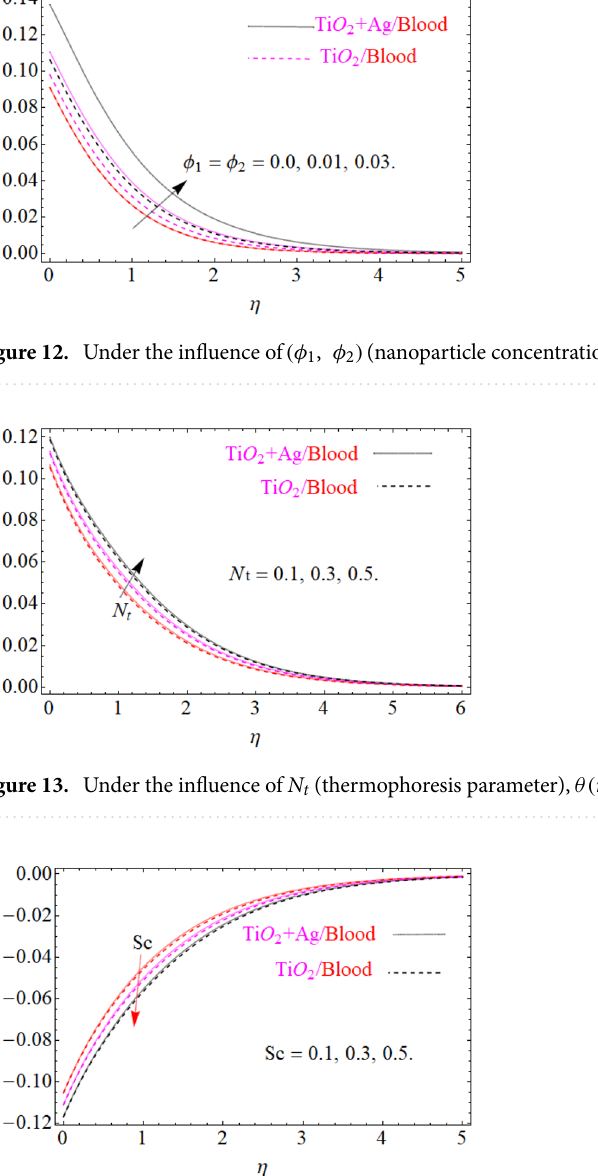
Figure 14. Under the influence of Sc (Schmidt number), �(η) .